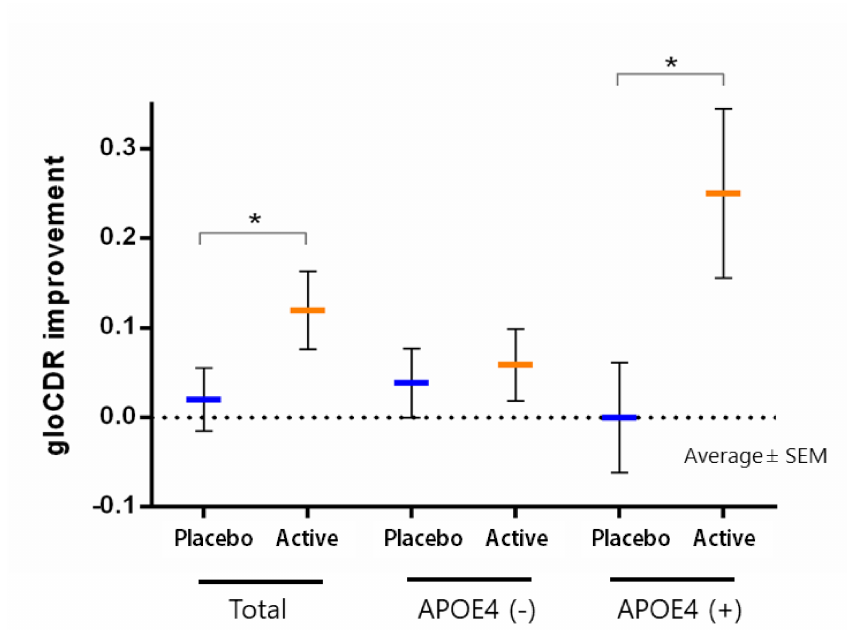
Figure 1. The improvement of gloCDR score in ApoE4 + mild cognitive impairment (MCI) patients, who took imidazole dipeptide supplementation for 12 weeks [26]. Average ± SEM are shown in histogram. * p <